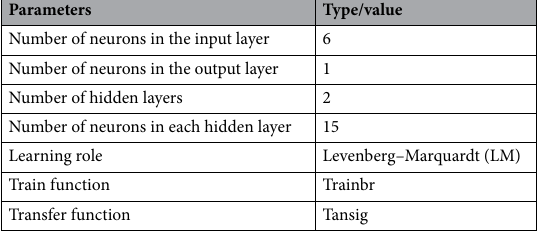
Table 1. Configuration details of MLP